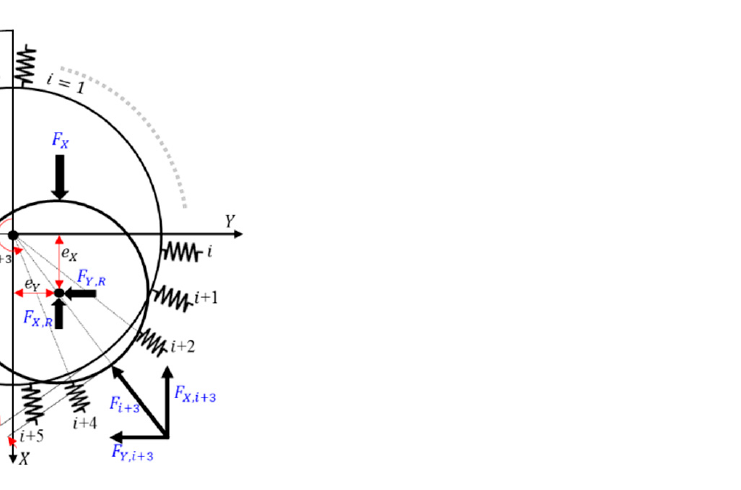
Figure 3. Coordinate systems for the structural deflection model with equivalent springs of the GFPB.